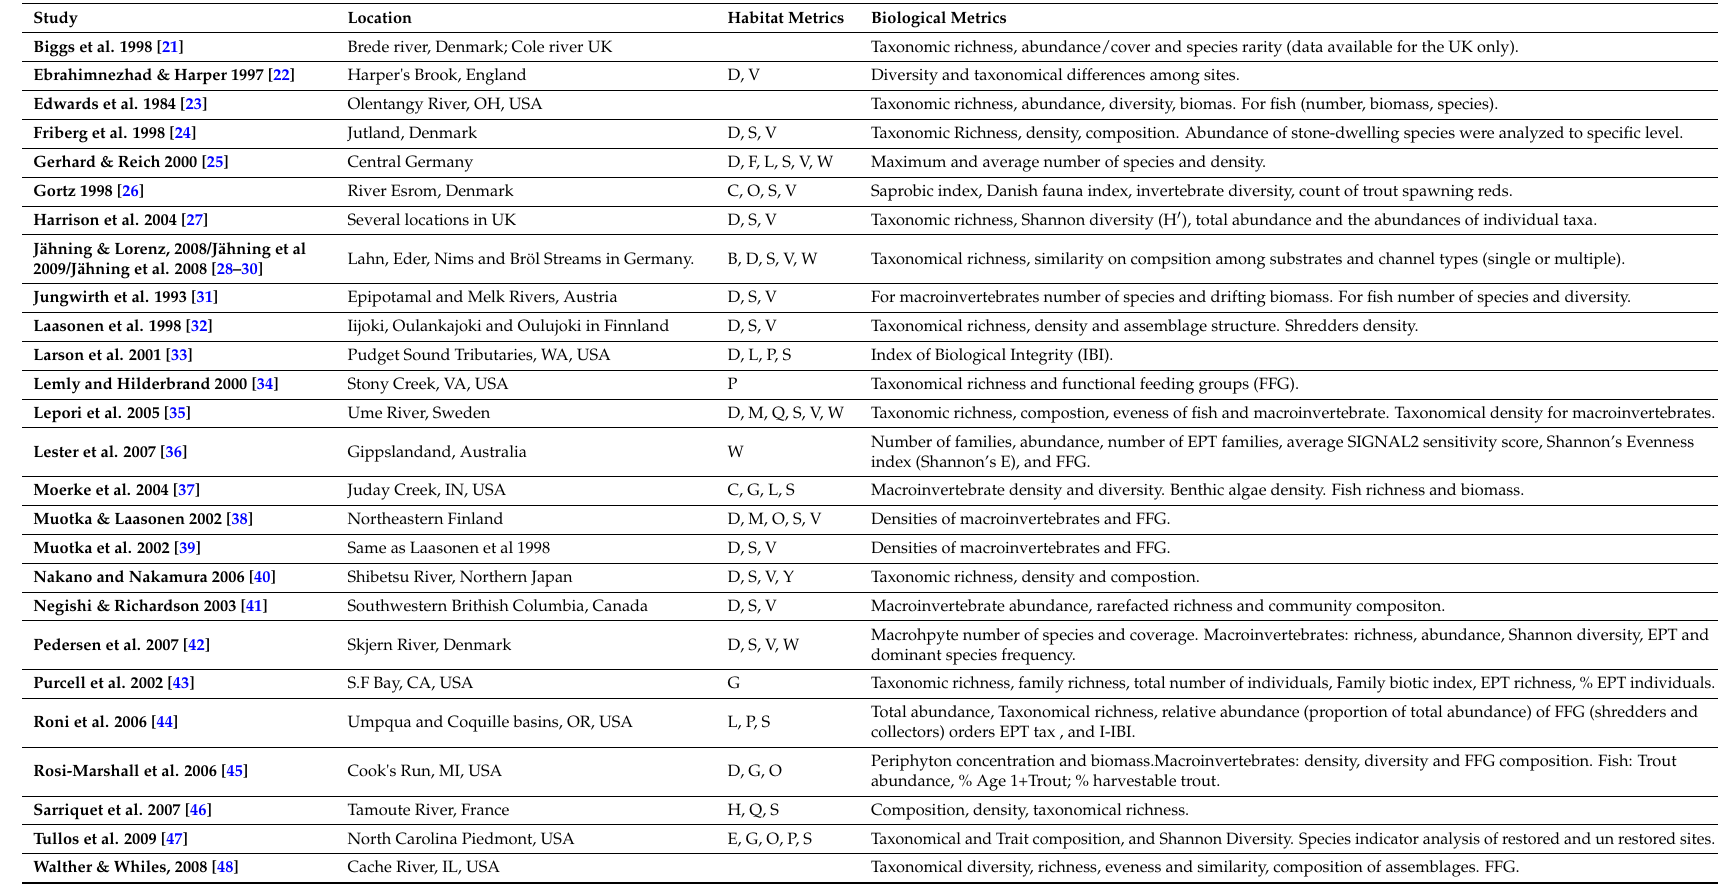
Table 1. Attributes of Studies Reviewed by Miller et al. (2010) and Palmer et al.